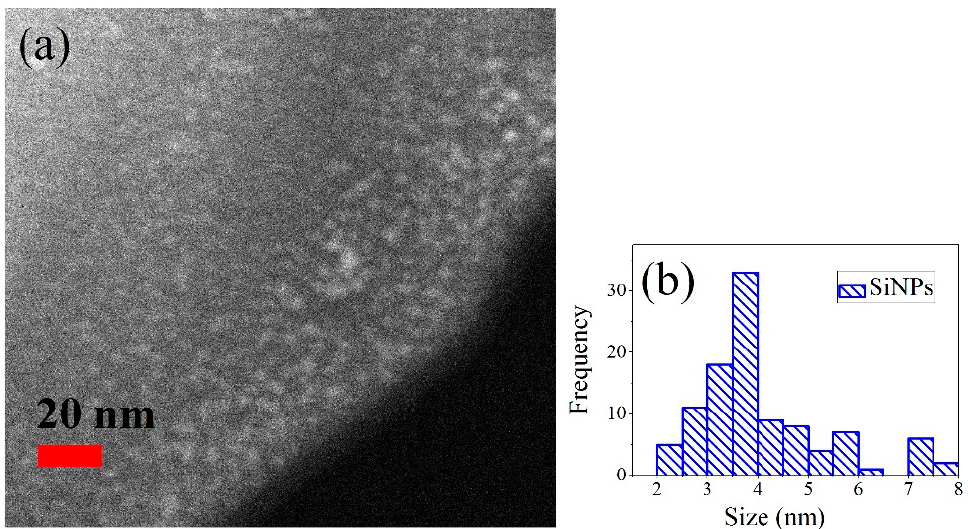
the UV. Figure 2b shows the Tauc plots to find an estimation of the average bandgap of the samples.